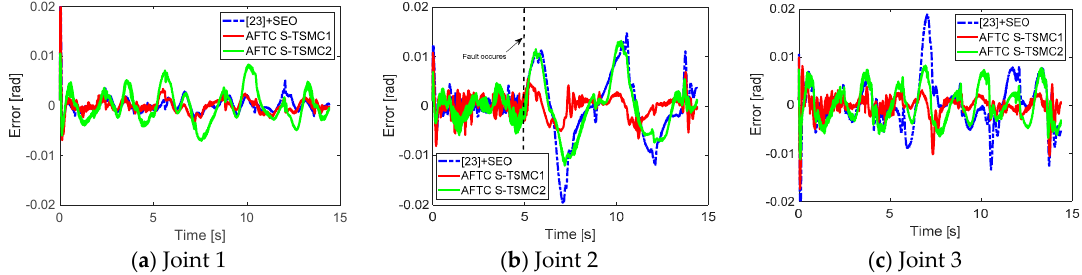
Figure 9. Fault estimation results with a single joint fault occurs at Joint 2.